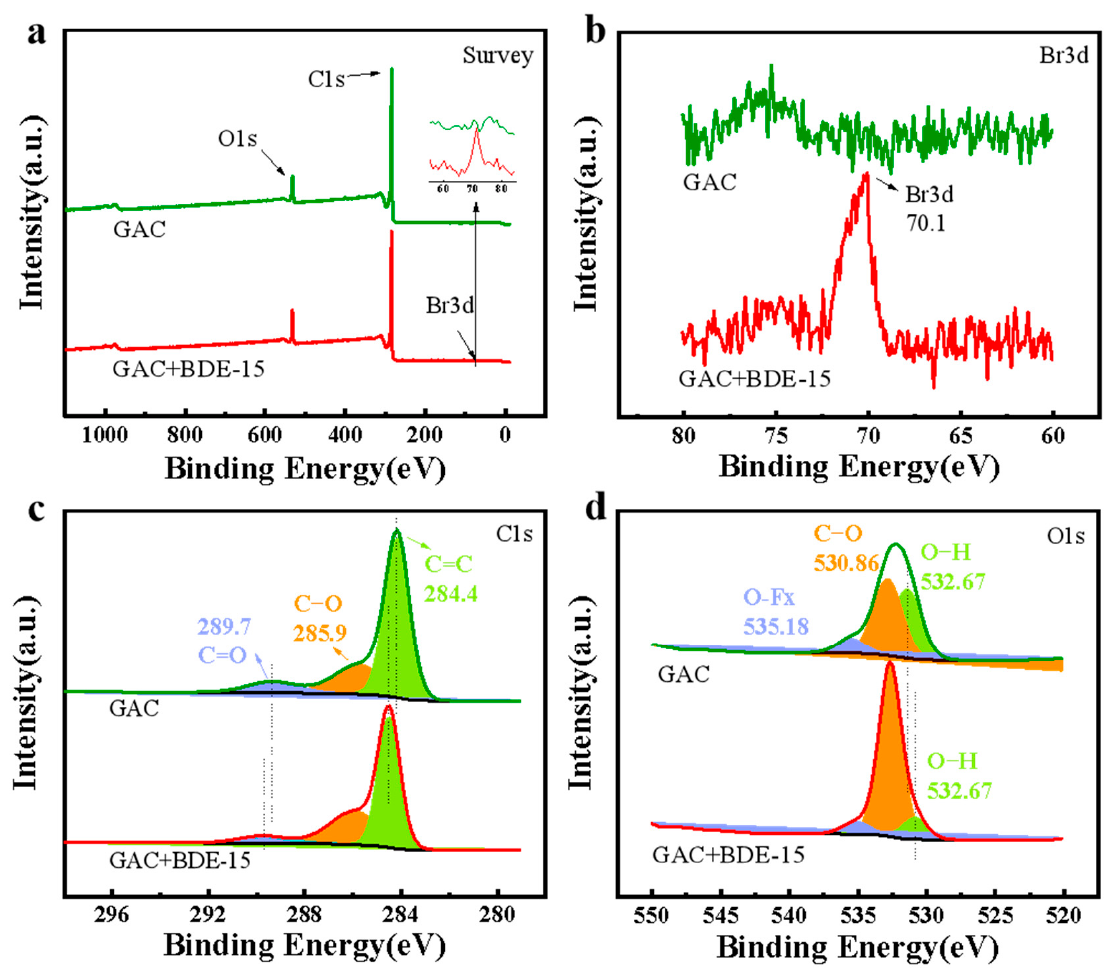
Figure 7. XPS full spectrum ( a ), Br 3d spectra ( b ), C 1s spectra ( c ) and O 1s spectra ( d ) of GAC before and after adsorption.